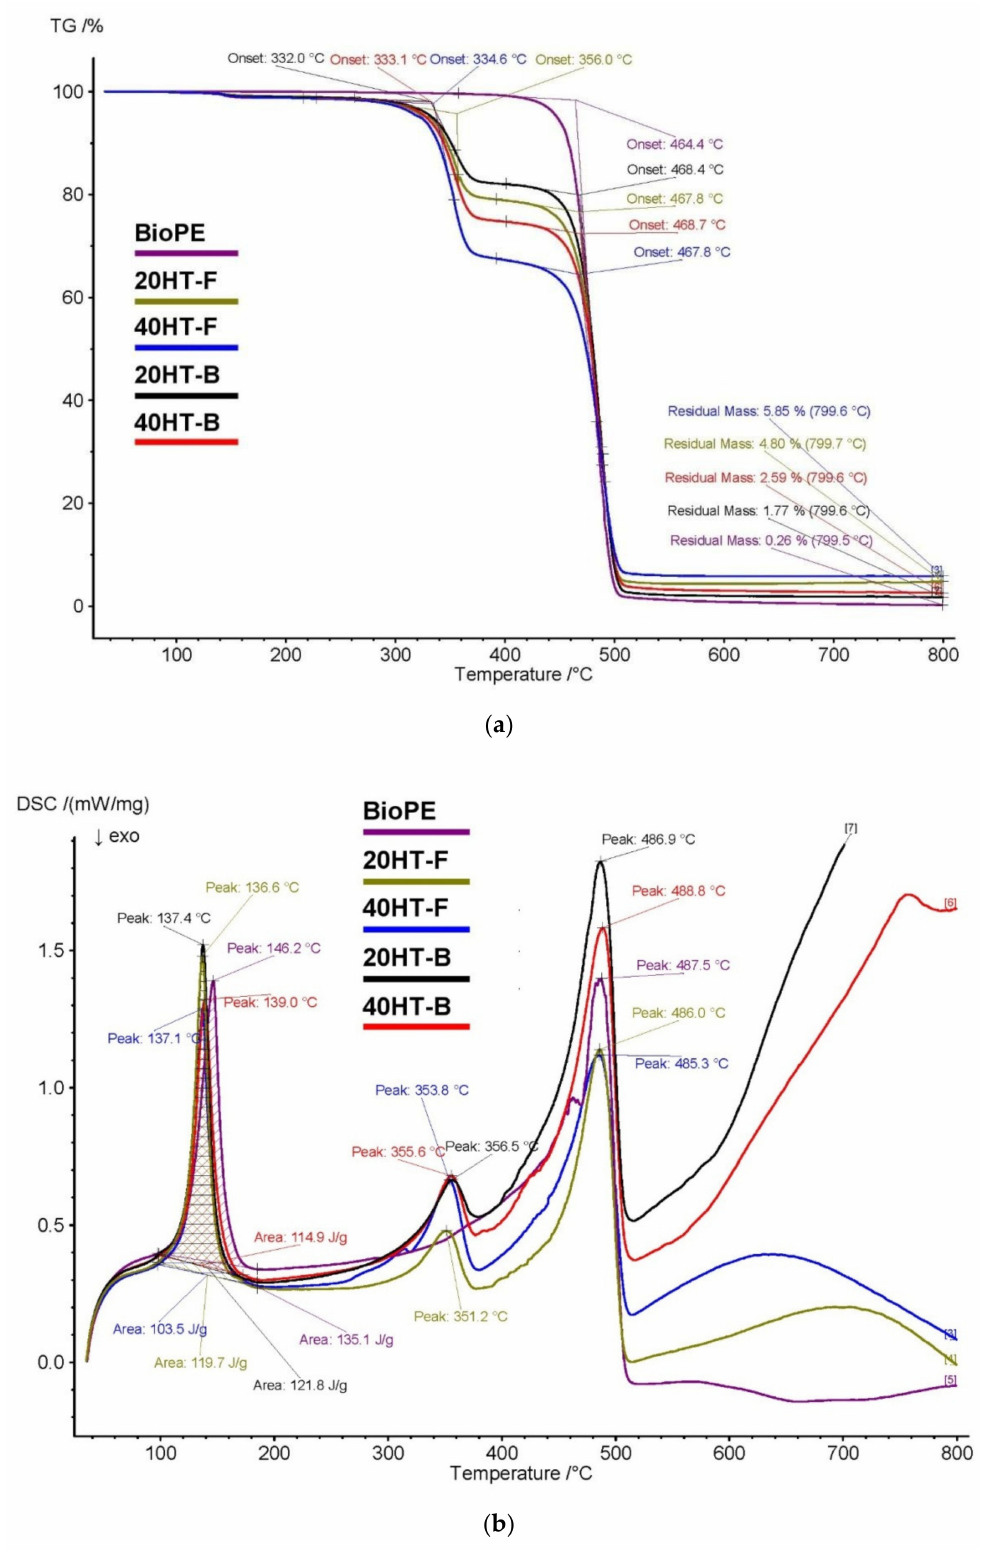
Figure 5. Thermo-gravimetric analysis ( a ) and di ff erential scanning calorimetric ( b ) of the